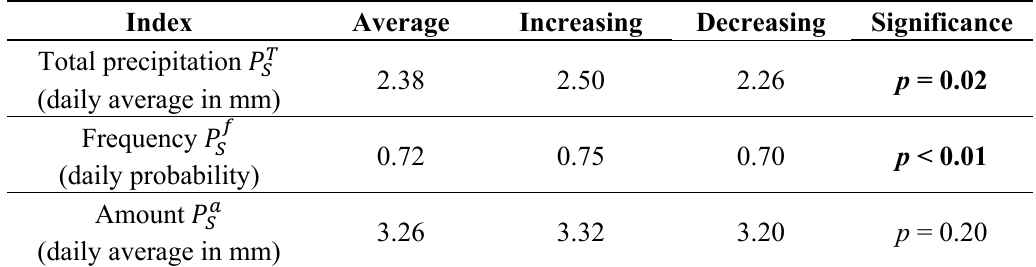
Table 3. Precipitation indices during summer months associated with the increasing and decreasing phases of the 12-y cycle*.